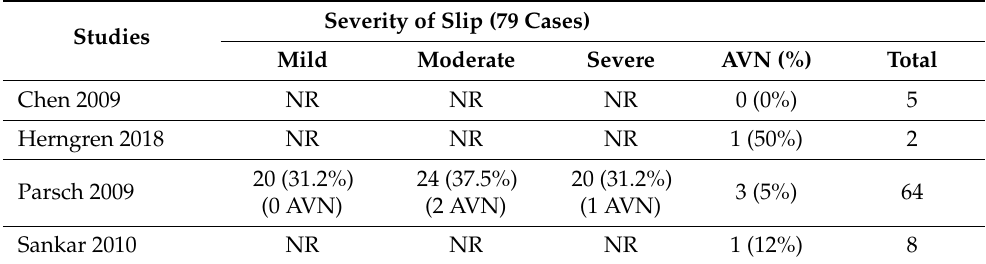
Table 3. Number of cases and rates of AVN according to severity of slip in studies in which the Parsch method was